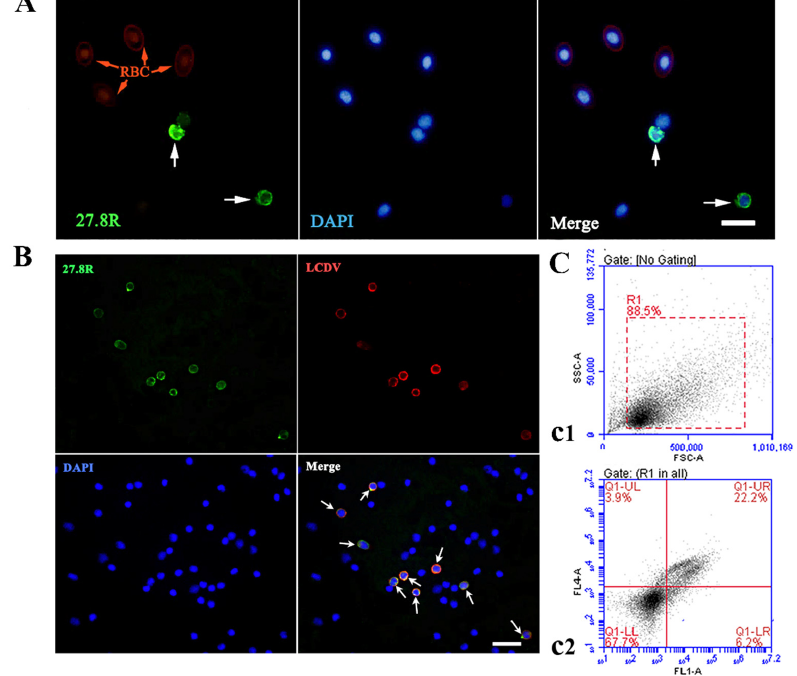
Figure 3. Detection of the 27.8R in whole blood cells and its co-localization with LCDV in PBLs at 3 h post in-vivo infection in flounder. ( A ) Detection of the 27.8R in whole blood cells. Red blood cells (RBCs, red arrow) were non-specifically fluoresced in red by Evan’s blue dye. The positive green signals (white arrows) represented the location of the 27.8R protein in some leukocytes. Cell nuclei